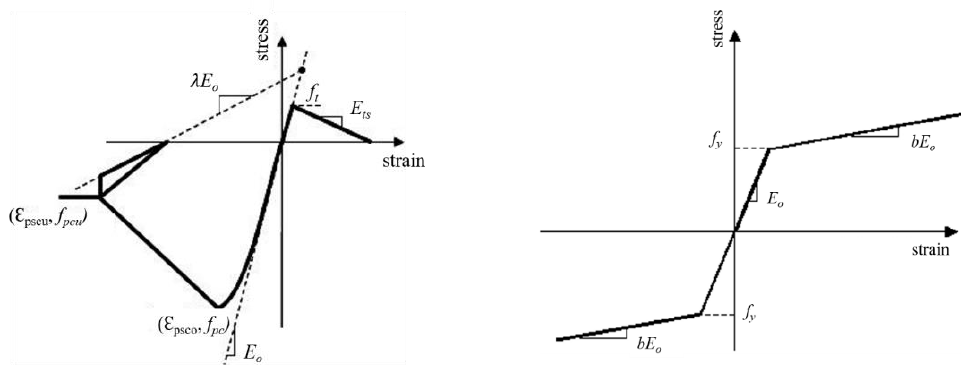
Figure 4. Material models for concrete ( left ) and steel ( right ) adapted from Opensees manual [94]. In the concrete model, f pc stands for concrete compressive strength at 28 days and f pcu for concrete crushing strength. E o and E ts stand for initial elastic tangent and tension softening stiffness, respectively. Ɛ psco and Ɛ pscu are concrete strain at maximum and ultimate strengths, respectively. 𝜆 represents the ratio between unloading slope at ultimate strain and initial slope. f t is the tensile strength of concrete. In the steel model, f y stands for yield stress in tension, E o is modulus of elasticity and b is the strain hardening ratio. The values adopted for concrete and steel models are given in Table 4. Table 4. Material properties for concrete and steel models used for modeling frames.